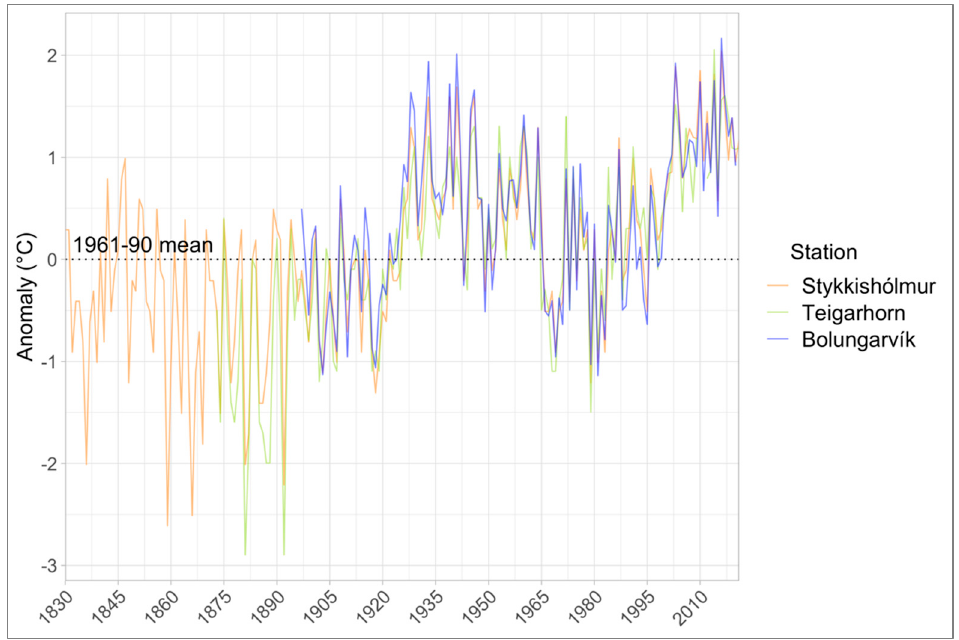
Figure 12. Average temperature anomalies over time for Stykkishólmur, Teigarhorn and Bolungarvík.